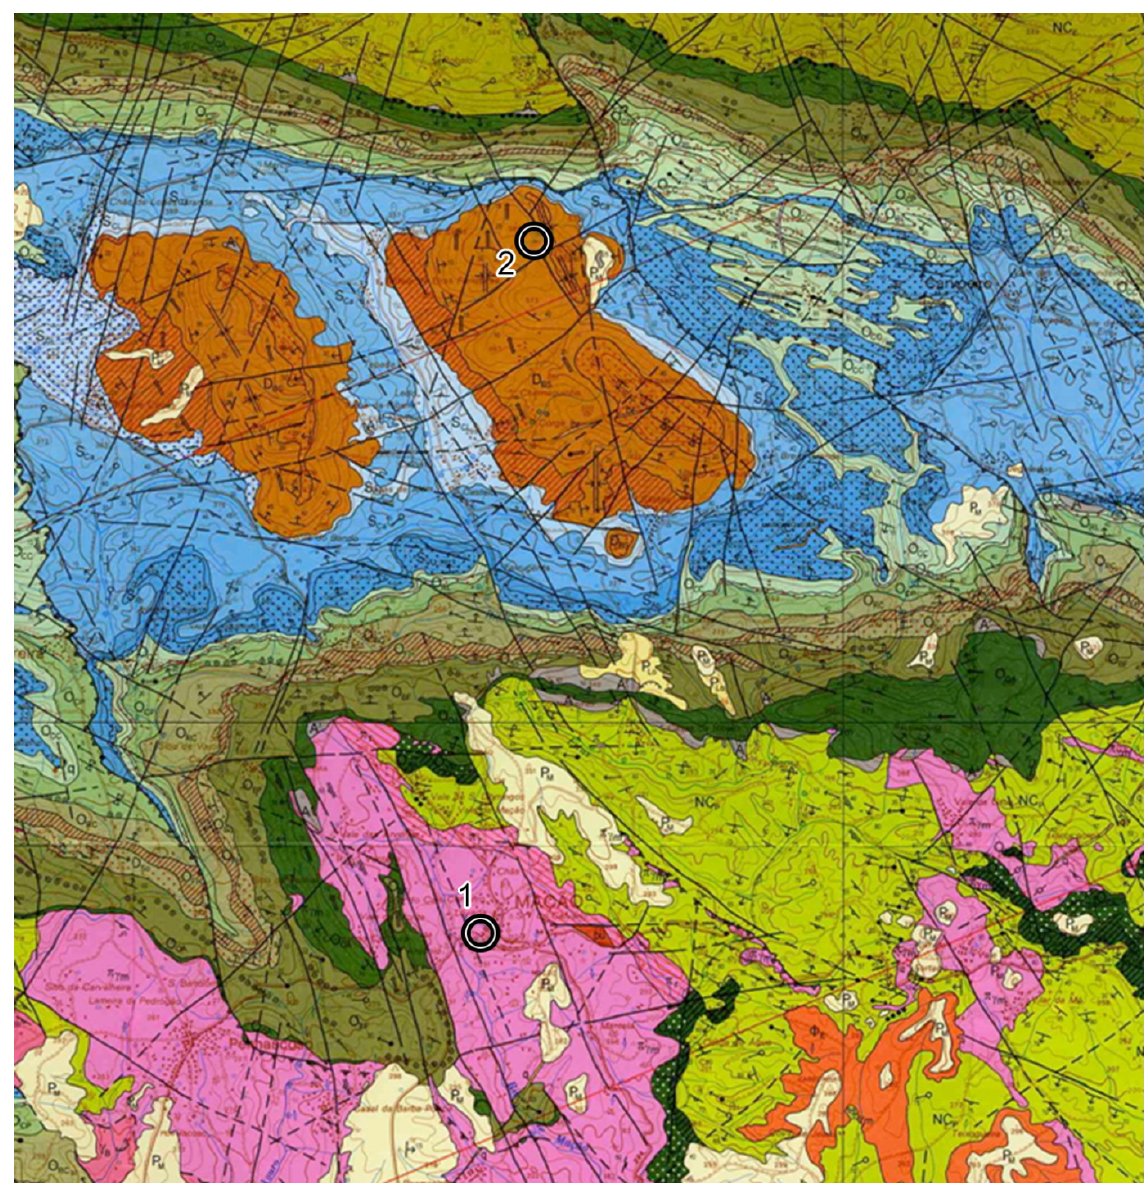
Figure 3. Localization of the site in the geologic map of Portugal. 1 - Village of Mação; 2 - Lagoa do